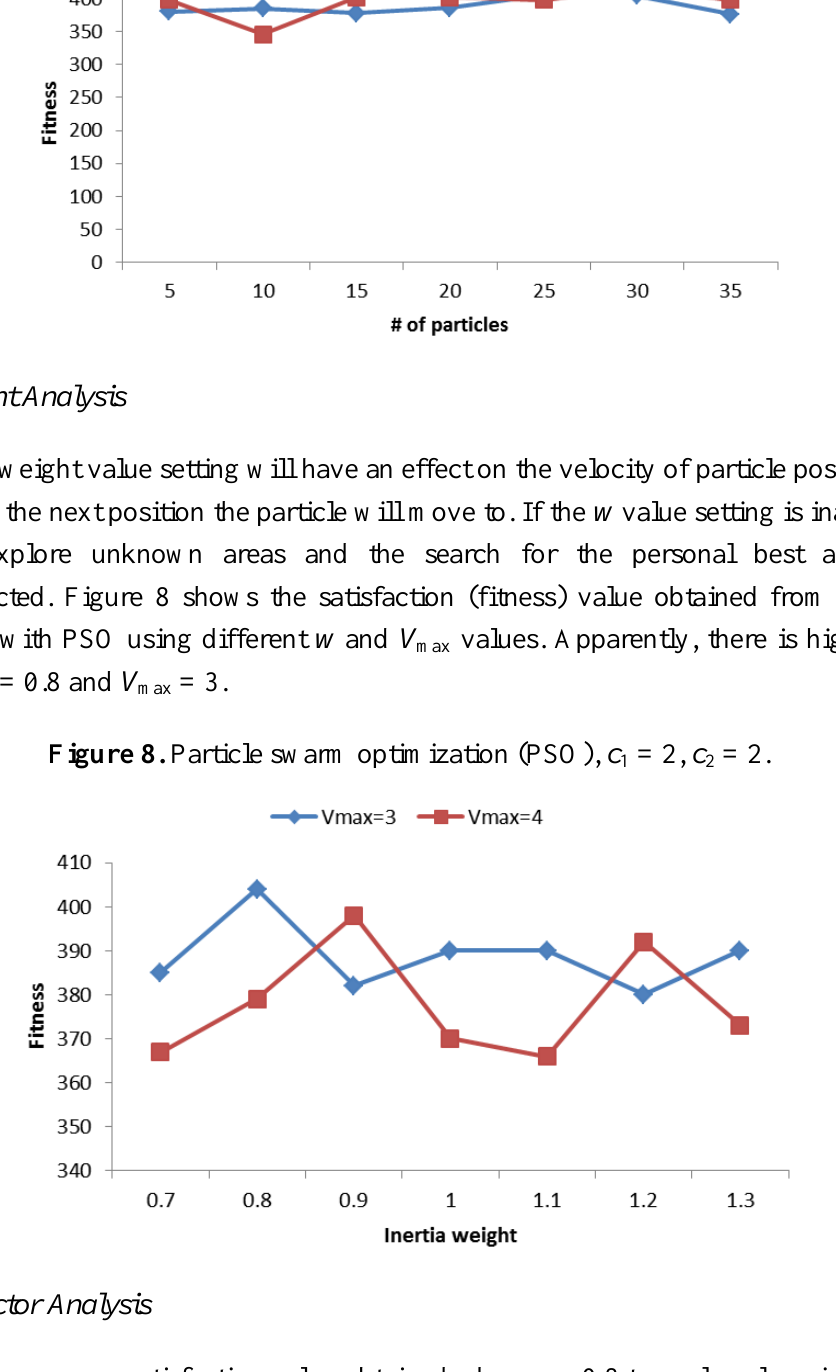
Figure 7. Swarm sizes verse average fitness (SPSO: X = 0.72984, c PSO: w = 0.7, c